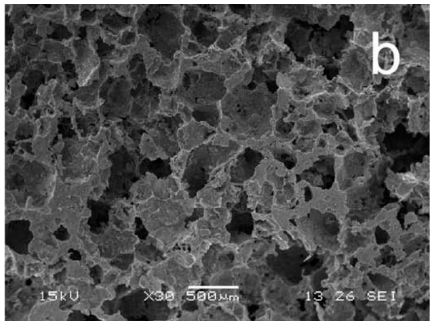
Figure 6. ( a ) A HAP scaffold with highly defined and regular pore sizes, shapes and interconnectivities